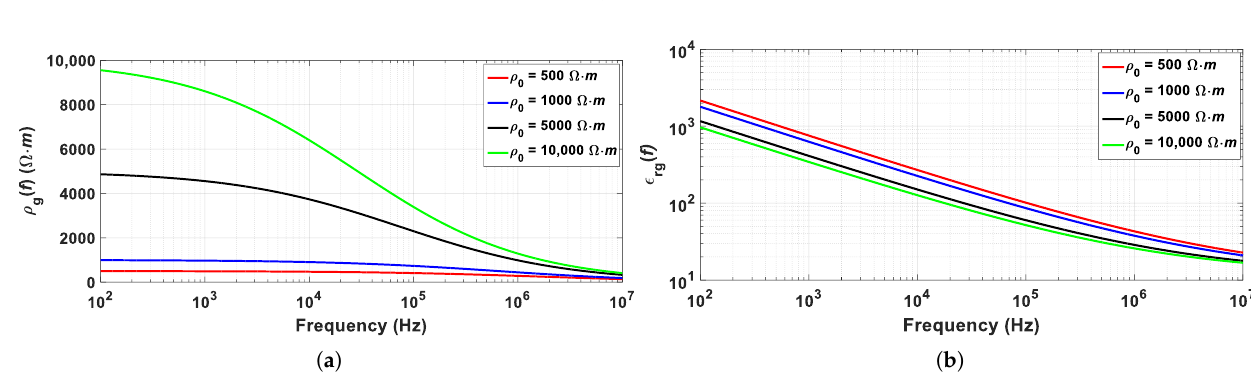
Figure 2. Frequency-dependent soil parameters for soils that have a 100 Hz resistivity ρ 0 of 500, 1000, 5000 and 10,000 Ω · m, calculated using (23) and (24) ( a ) Resistivity and ( b ) relative